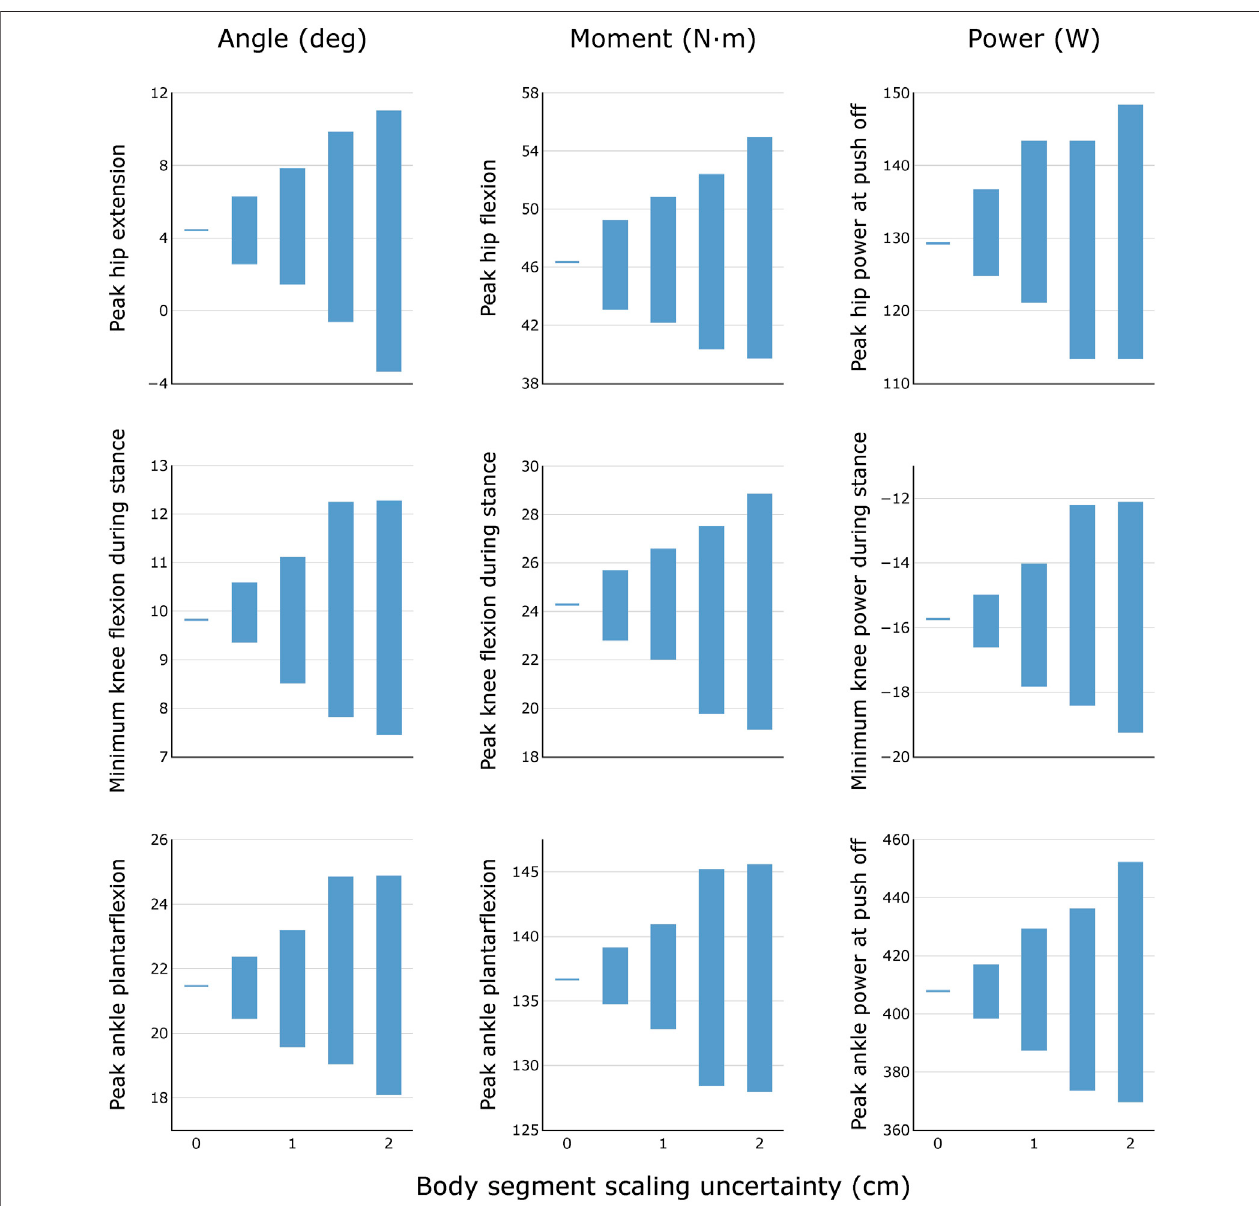
FIGURE 5 | Variability in peak joint angles, moments, and powers during healthy walking for different levels of body segment scaling uncertainty. Results were obtained by generating N = 100 equally probable models at each level of uncertainty.